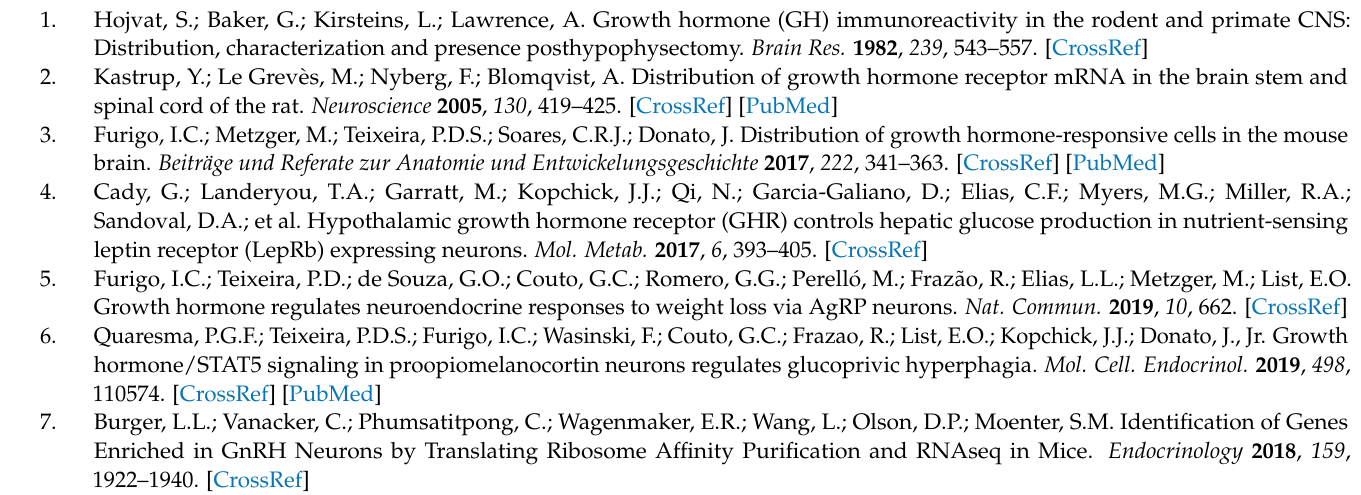
treatment, Figure S5. Acute activation of ARCGHR neurons increases ambulatory activity, Table